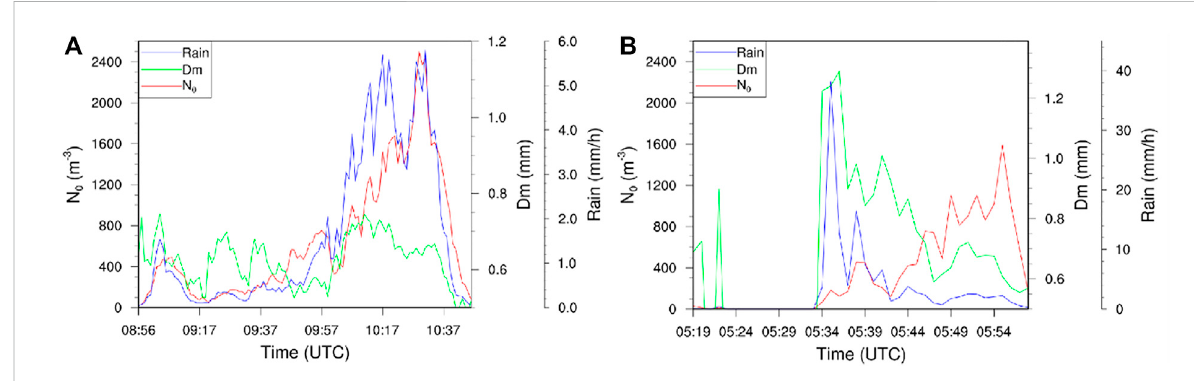
FIGURE 8 Raindrop spectrometer observations of (A) PV thunderstorm and (B) TC